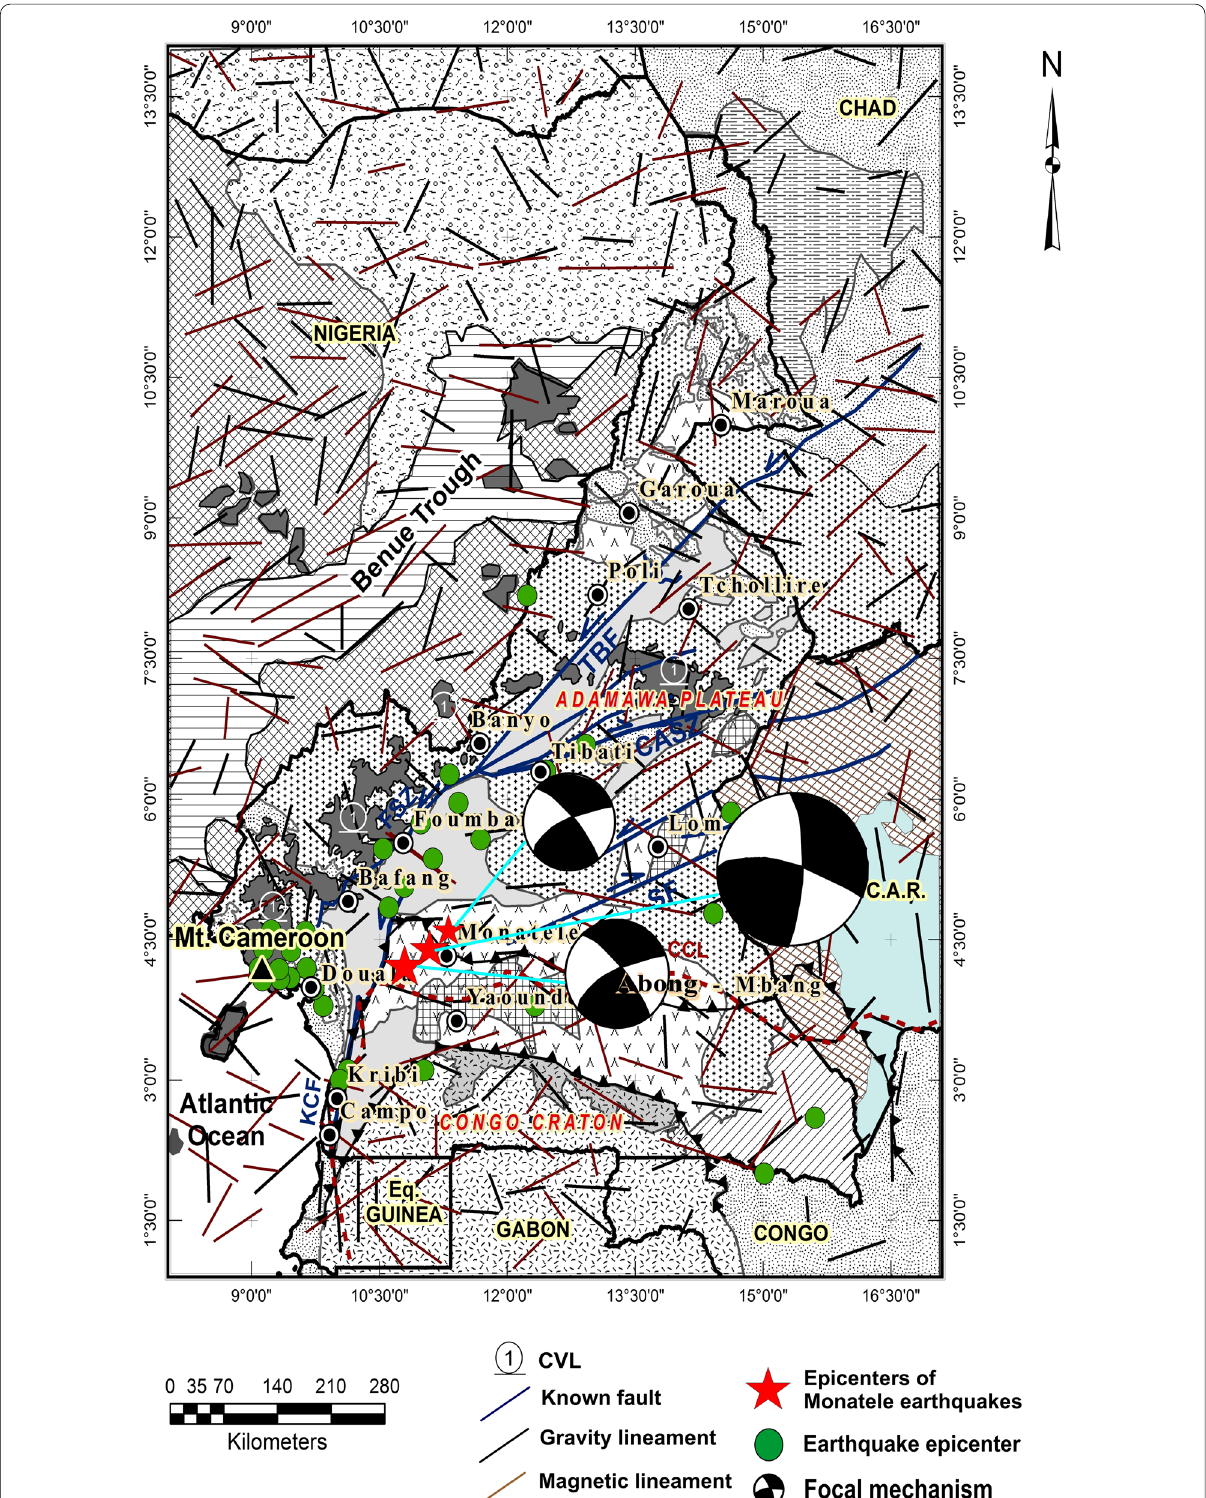
Fig. 13 Cartography of lineaments correlated to some tectonic earthquakes that occurred recently in Cameroon; Green circles are the earthquakes recorded by the network of temporary broadband stations; Red stars represent the epicenters of the Monatele event. Spheres are the focal mechanism for main and aftershocks. Black and white quadrants represent the compression and dilatation,